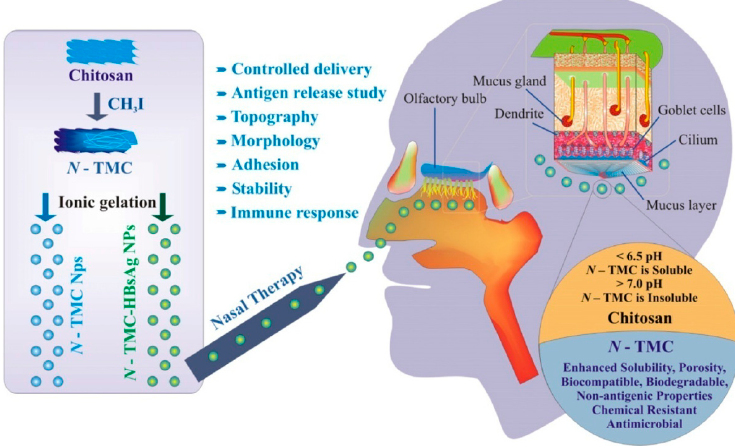
Figure 6. Schematic flow chart representing the preparation of TMC NPs, HBsAg loading and intra-nasal delivery of HBsAg loaded TMC NPs. The nasal delivery and transportation mechanism of vaccine-loaded NPs in the nasal septum area are explained. Anatomy of the nasal area and the advantages of TMC NPs over chitosan are also shown [34].